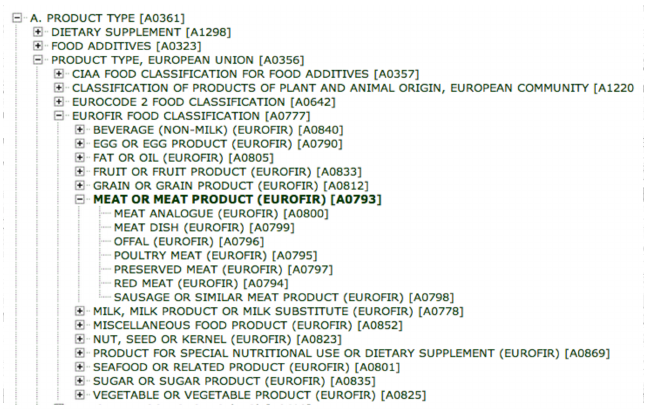
Figure 2. Example of LanguaL description and